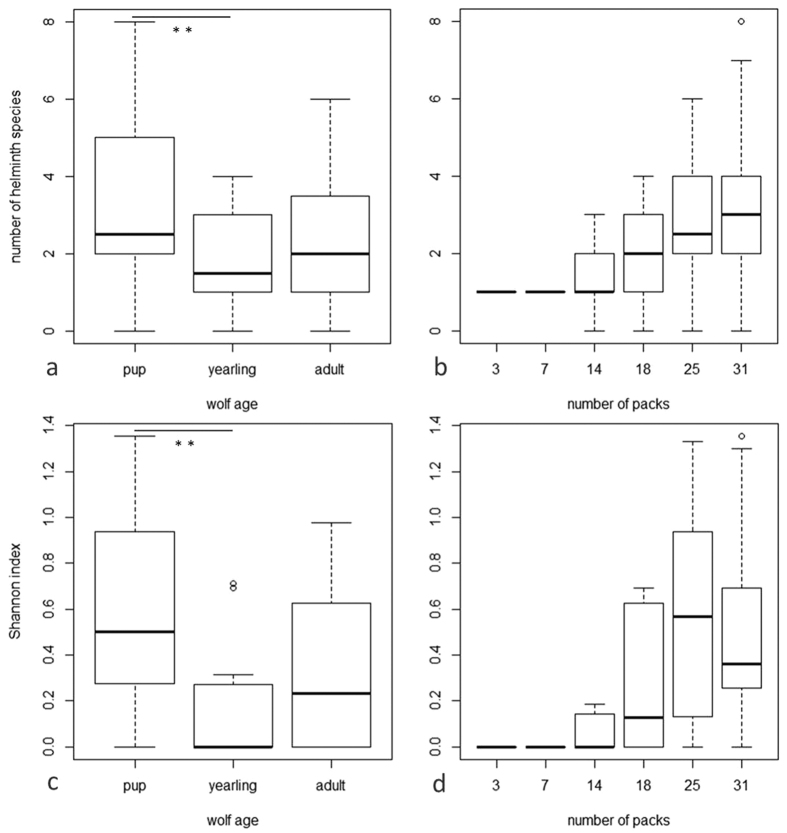
Relevant effectors of helminth species richness and diversity (Shannon index) in wolves from the CEL population.Helminth species richness (a,b) and helminth diversity (c,d) vary with wolf age significantly decreasing from pups to yearlings (npup = 21, nyearling = 16, nadult = 14) and increase with wolf population size (n3packs = 1, n7packs = 1, n14packs = 8, n18packs = 11, n25packs = 14, n31packs = 16). Dots represent outliers. Box plot edges depict the quartiles for number of helminths species (a,b) and the Shannon index (c,d). Whiskers extend to non-outlier extremes. Statistical significance was calculated using a general linear model.